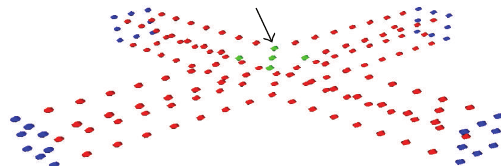
Figure 8: The cross mesh is constrained at the blue nodes and pushed towards the green